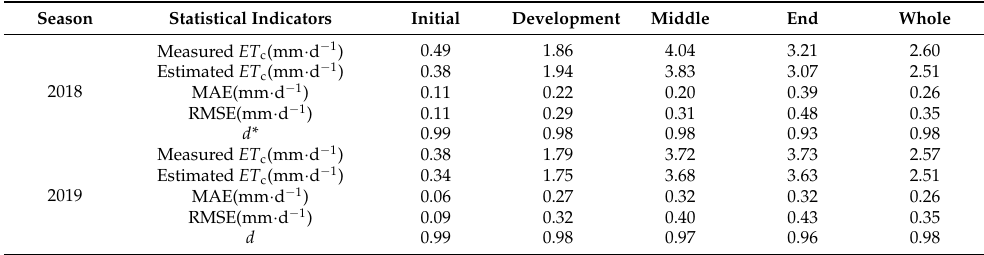
Table 3. Statistical indicators of measured and estimated crop evapotranspiration ( ET c ) for greenhouse-grown eggplant in 2018 and